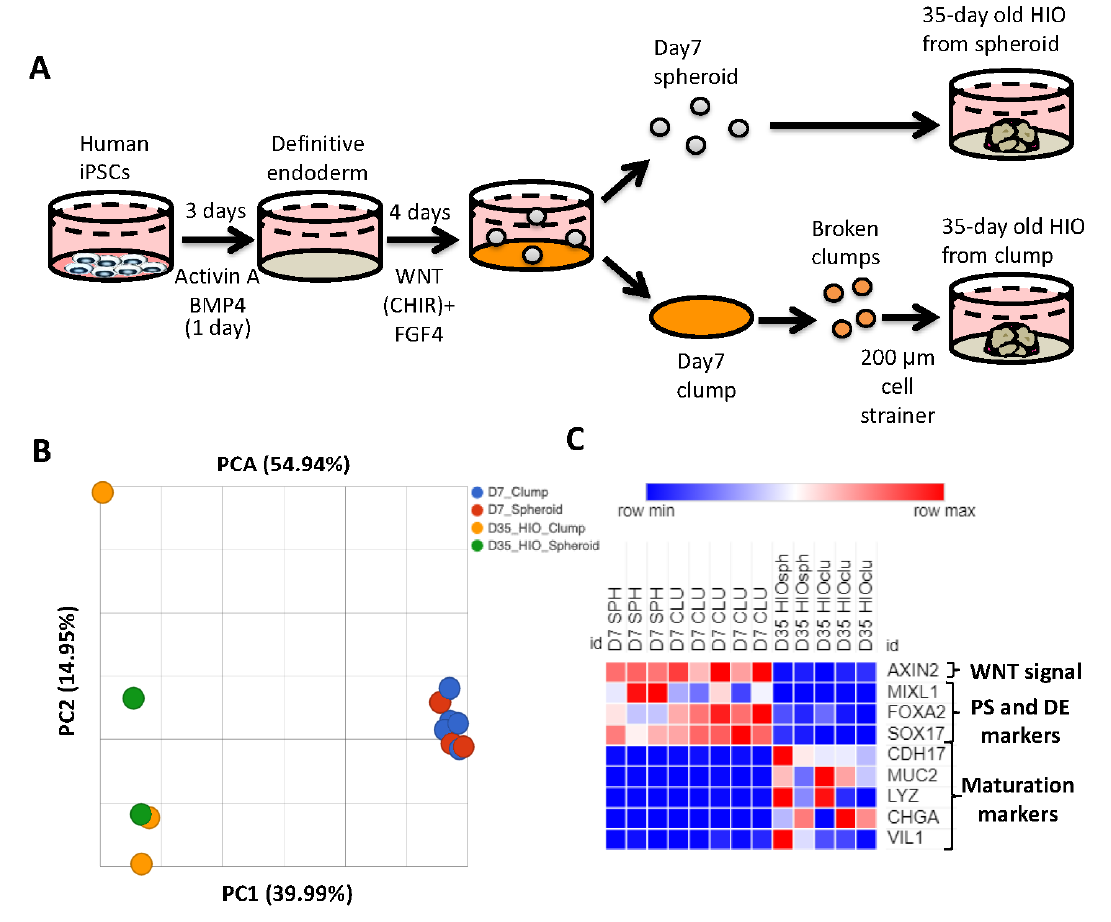
Figure 1. The source of mid/hindgut tissue does not affect HIO growth or maturation. ( A ) Schematic of mid/hindgut tissue generation and development of HIOs from spheroids or clumps. ( B ) Principal component analysis spheroid and clump derived mid/hindgut tissue and 35-day-old HIOs. ( C ) Heatmap of the WNT target gene AXIN, markers of primitive streak and maturation markers from TPM (transcripts per million) values.